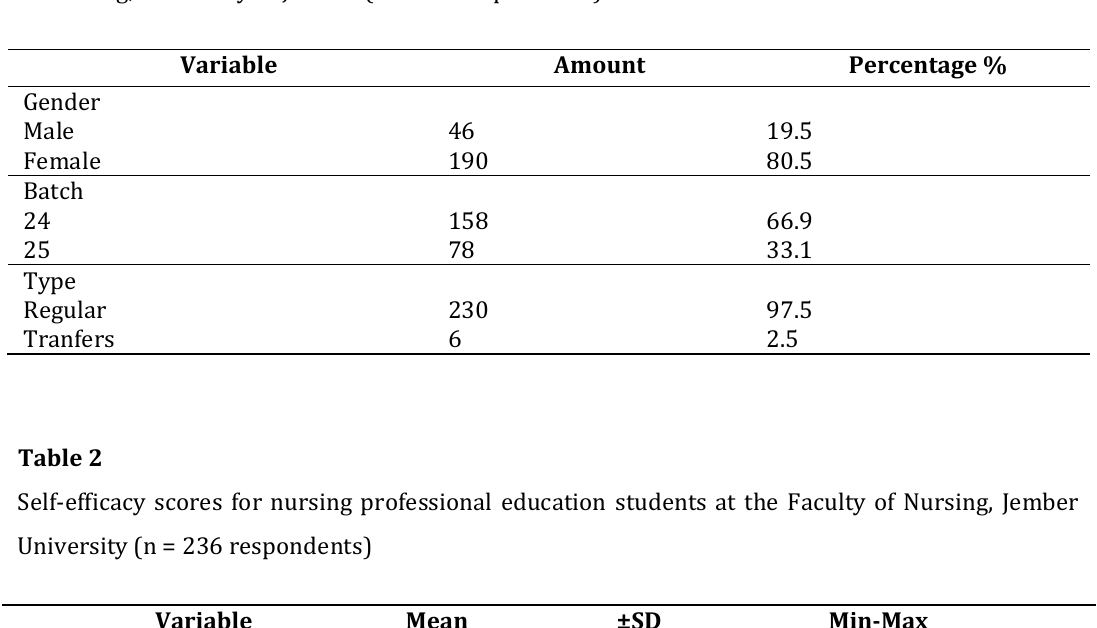
Distribution of student characteristics by gender, class, and type of student admission at the Faculty of Nursing, University of Jember (n = 236 respondents)